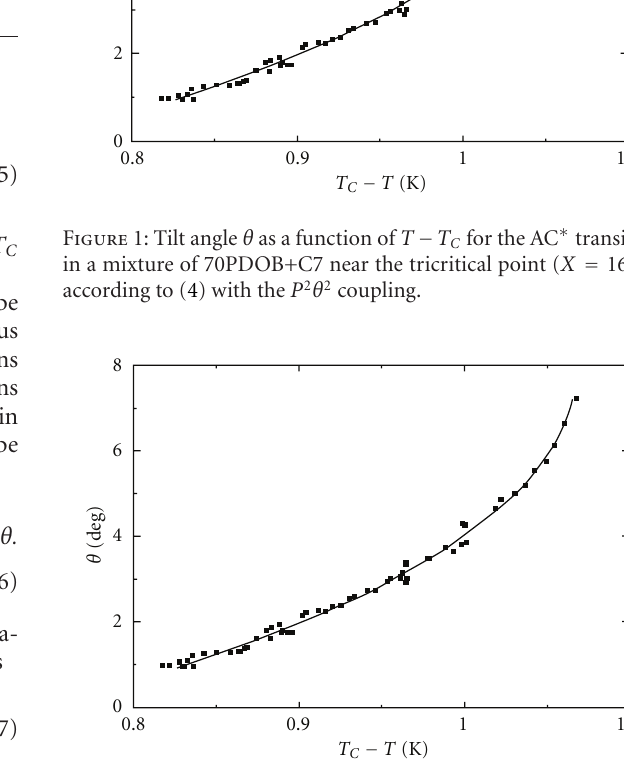
Figure 2: Tilt angle θ as a function of T − T C for the AC ∗ transition in a mixture of 70PDOB+C7 near the tricritical point ( X = 16 . 92) according to (9) with the Pθ + P 2 θ 2